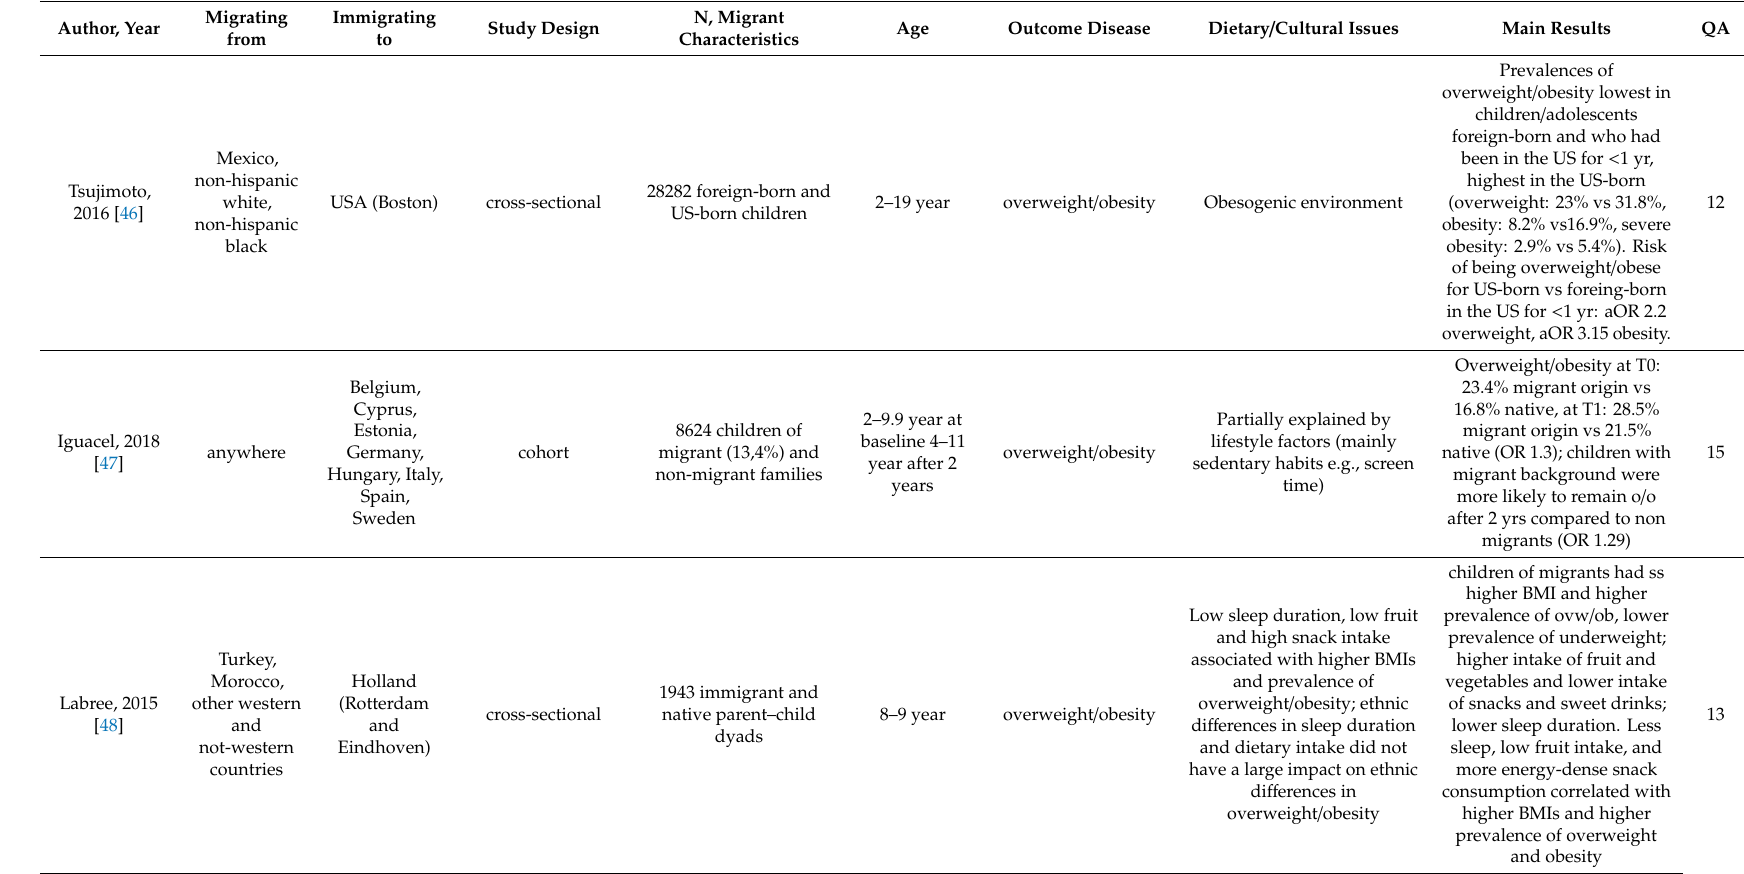
Table 3. Characteristics and main results of the included studies.